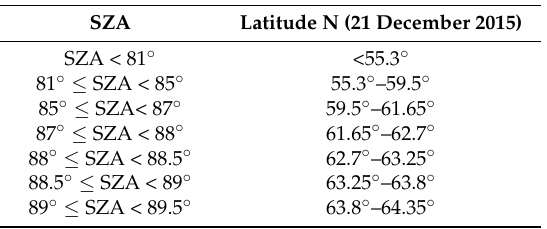
Table 3. Sun Zenith Angle classes used for the validation of the snow cover map as well as related latitudes north at the winter